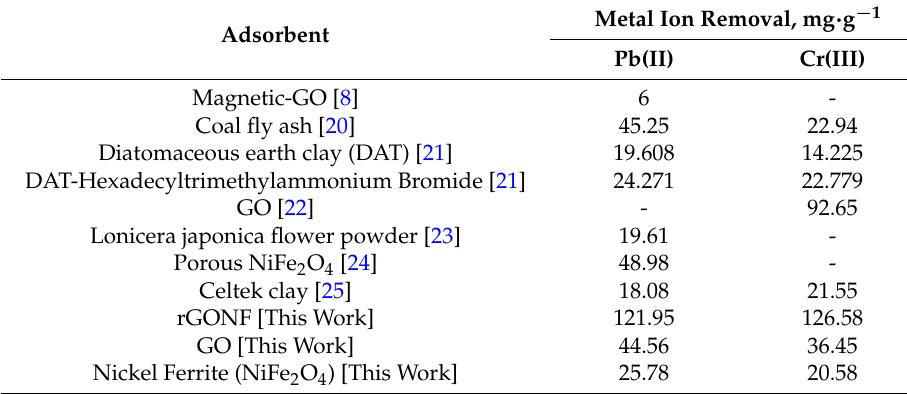
Table 1. Comparison of the adsorption capacities of reduced graphene oxide based nickel ferrite (rGONF) with the other reported adsorbents for Pb(II) and Cr(III). graphene oxide